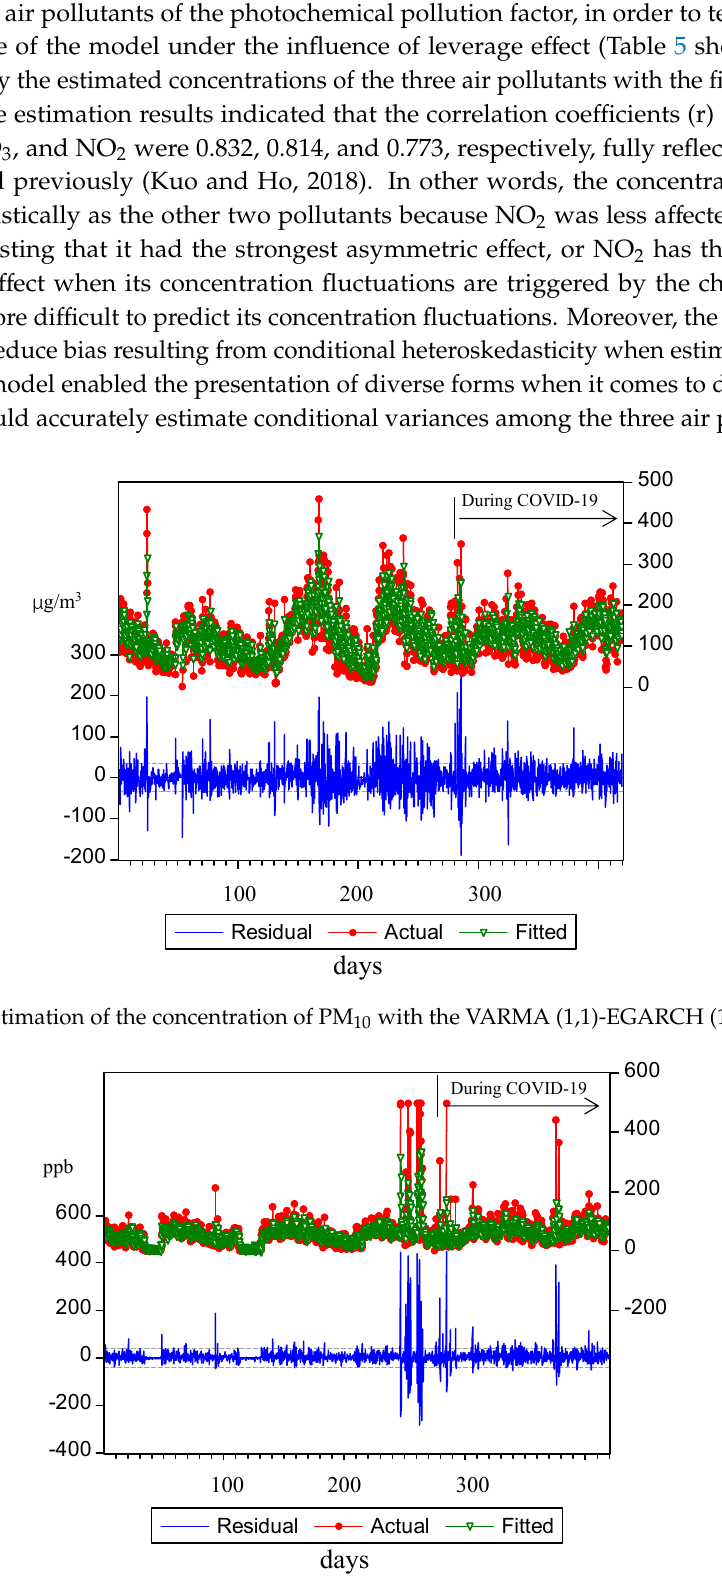
Figure 4. Estimation of the concentration of NO 2 with the VARMA (1,1)-EGARCH (1,1) model. 4. Conclusions This study adopted the VARMA-EGARCH model to explore the changes and influences of variation of air pollutants in the time series. This approach is unprecedented because there are barely any published studies on how multiple air pollutants change and influence each other in an Air Pollutant Control Area with the EGARCH model. Moreover, since the parameters of the traditional multivariate GARCH model are too complex, while the multivariate GARCH model cannot fully represent multivariate analysis results, we applied dummy variables from the EGARCH model to the variant formula to enable it to accurately estimate the variances of the three air pollutants and capture the seasonal fluctuations of air quality in the VARMA-EGARCH model. This study also applied the VARMA (1,1)-EGARCH (1,1) model to explore the relativity and trend of concentration of PM 10 , O 3 , and NO 2 in the time series. When PM 10 and NO 2 form in the atmosphere, their concentrations cannot be used to estimate the concentration of O 3 in the current